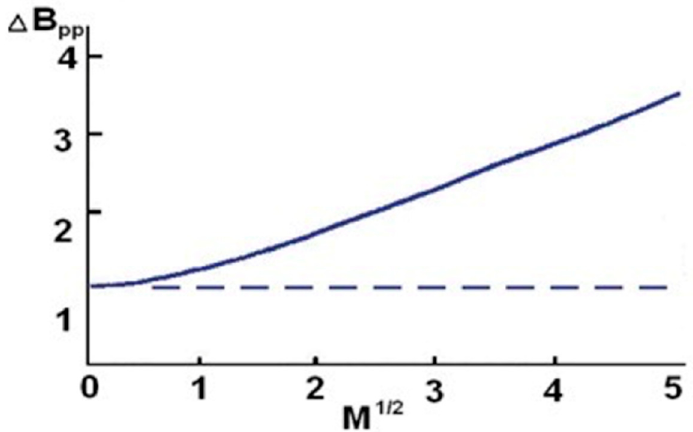
Figure 26. The effect of microwave power (M) on the width ( ∆ B pp ) of the EPR line widened uniformly (solid line) and non-uniformly (dotted line).